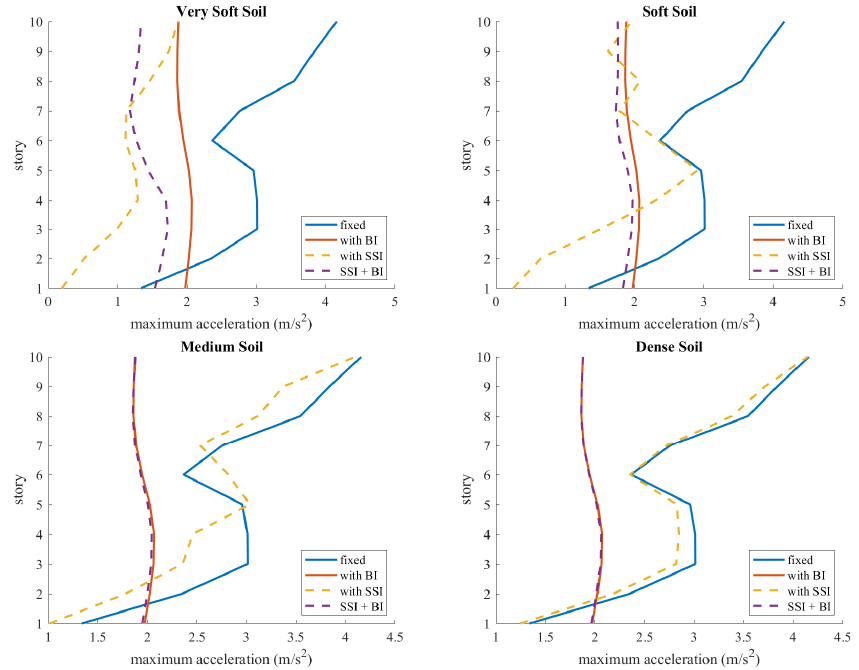
Figure 6. Maximum acceleration of each story for the ten ‐ story building (Kocaeli, 1999).